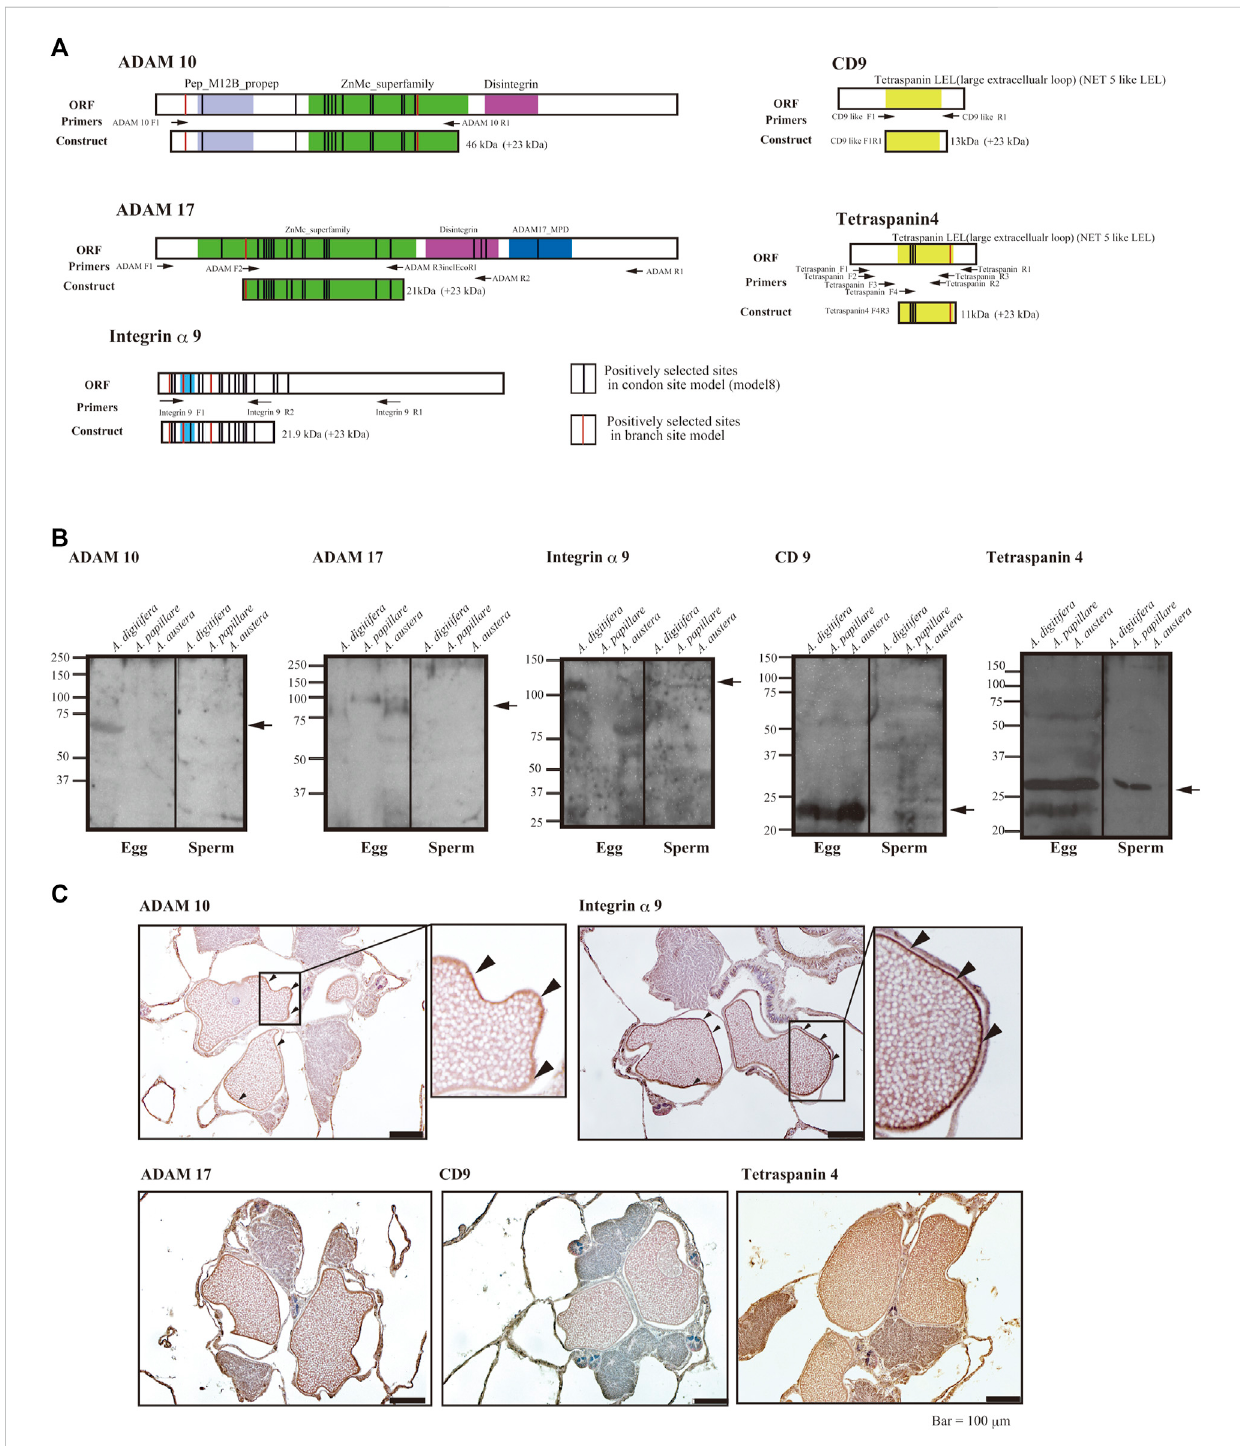
FIGURE 2 (A) Functional domains and positively selected sites of integrin α 9, tetraspanins, ADAMs, and region(s) of antigen for antibody generation, (B) immunoblot analyses, and (C) immunohistology with the antibodies against sperm and eggs of the coral Acropora. (A) Functional domains of open reading frames, location of primers, and positively selected sites are indicated (red indicates the branch site model and black, the codon site model). Upperpanelsarehydropathyplotsofdeducedaminoacidsequences. (B) Immunoblotanalyseswitheggsorspermof A.digitifera , A.papillare ,and A. austera . For tetraspanin 4 and CD9, 10% acrylamide gel was used to separate the proteins, and 7.5% gel was used for ADAMs and integrin α 9. (C) Localization of ADAM10, ADAM17, Integrin α 9, CD9, and Tetraspaning in about 1 week before the spawning of the coral A. digitifera . Arrowheads indicate the surface of oocytes. Bars = 100 μ